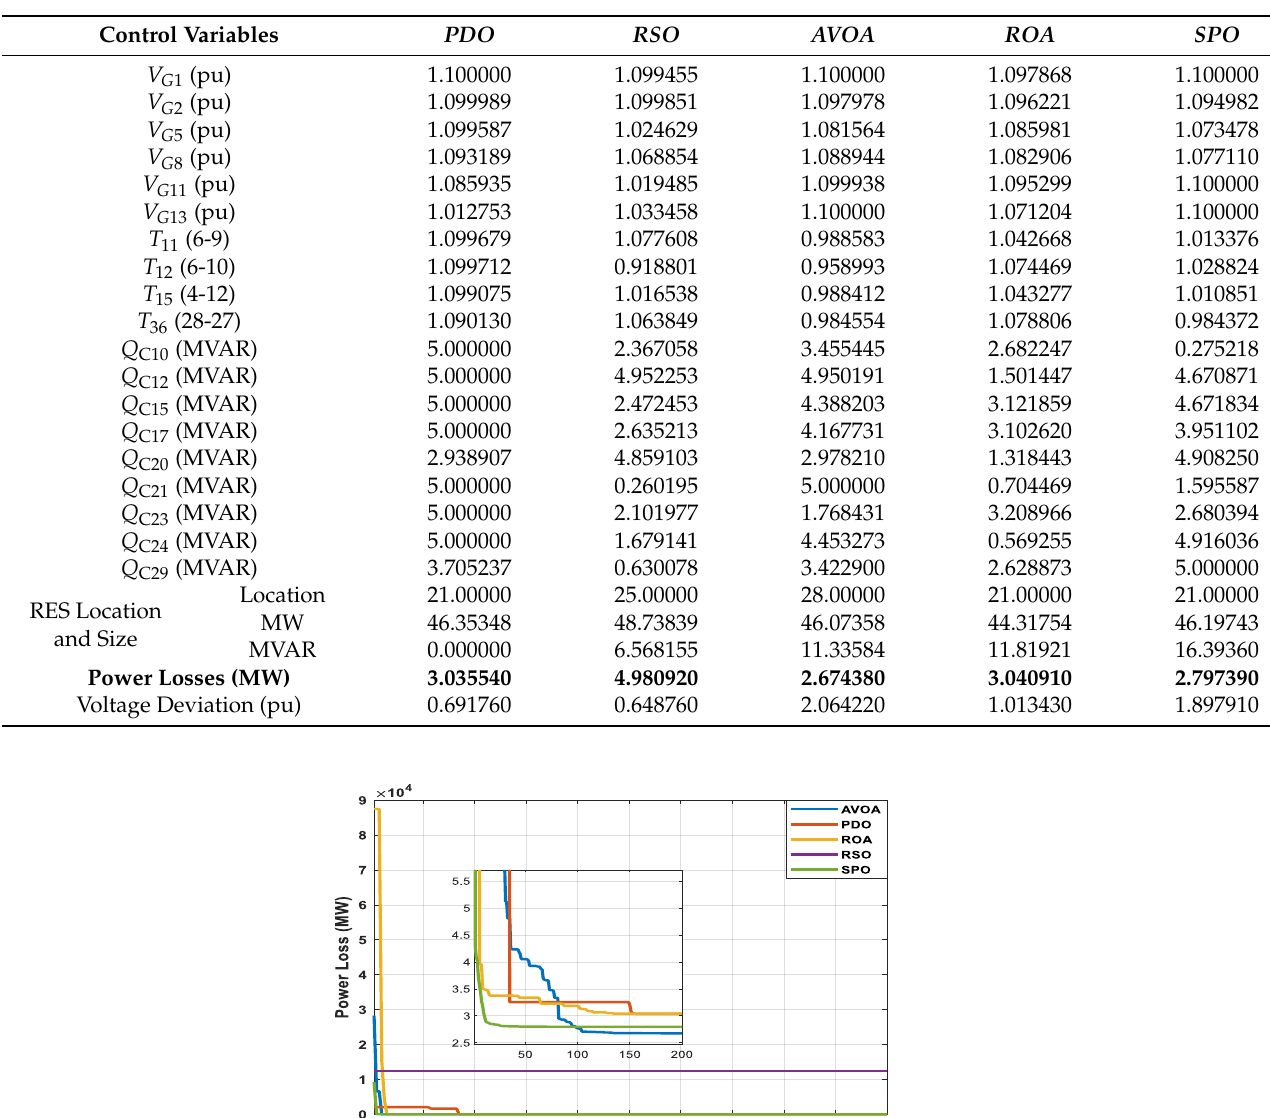
Table 15. Optimal IEEE 30-bus test system control variables for decline in power losses with incorpo- ration of RES.